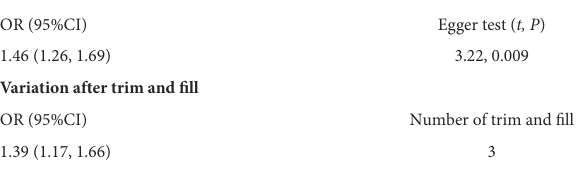
TABLE 3 Publication bias (Egger test) and sensitivity analysis (method of trim and fill) for included studies.